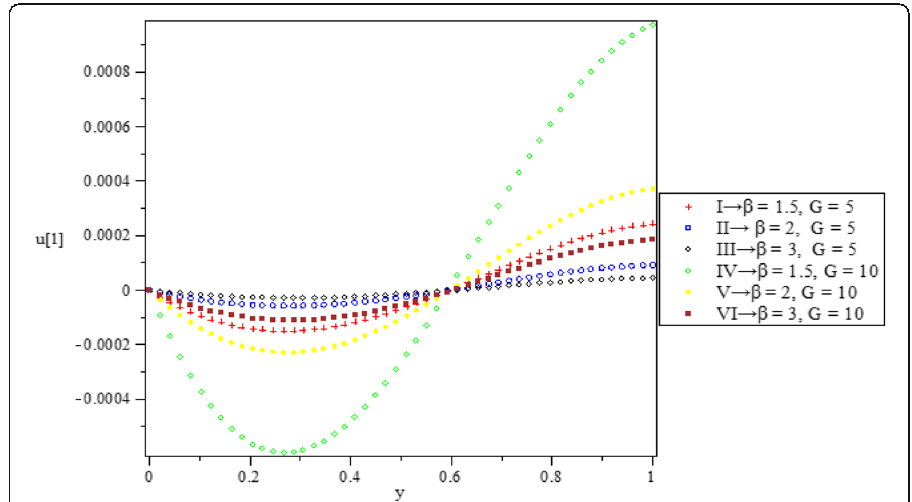
Fig. 16 First-order velocity (u[1] profile, r = − 1, ϵ = 0.25, P = 0.71 α = 0, and λ =